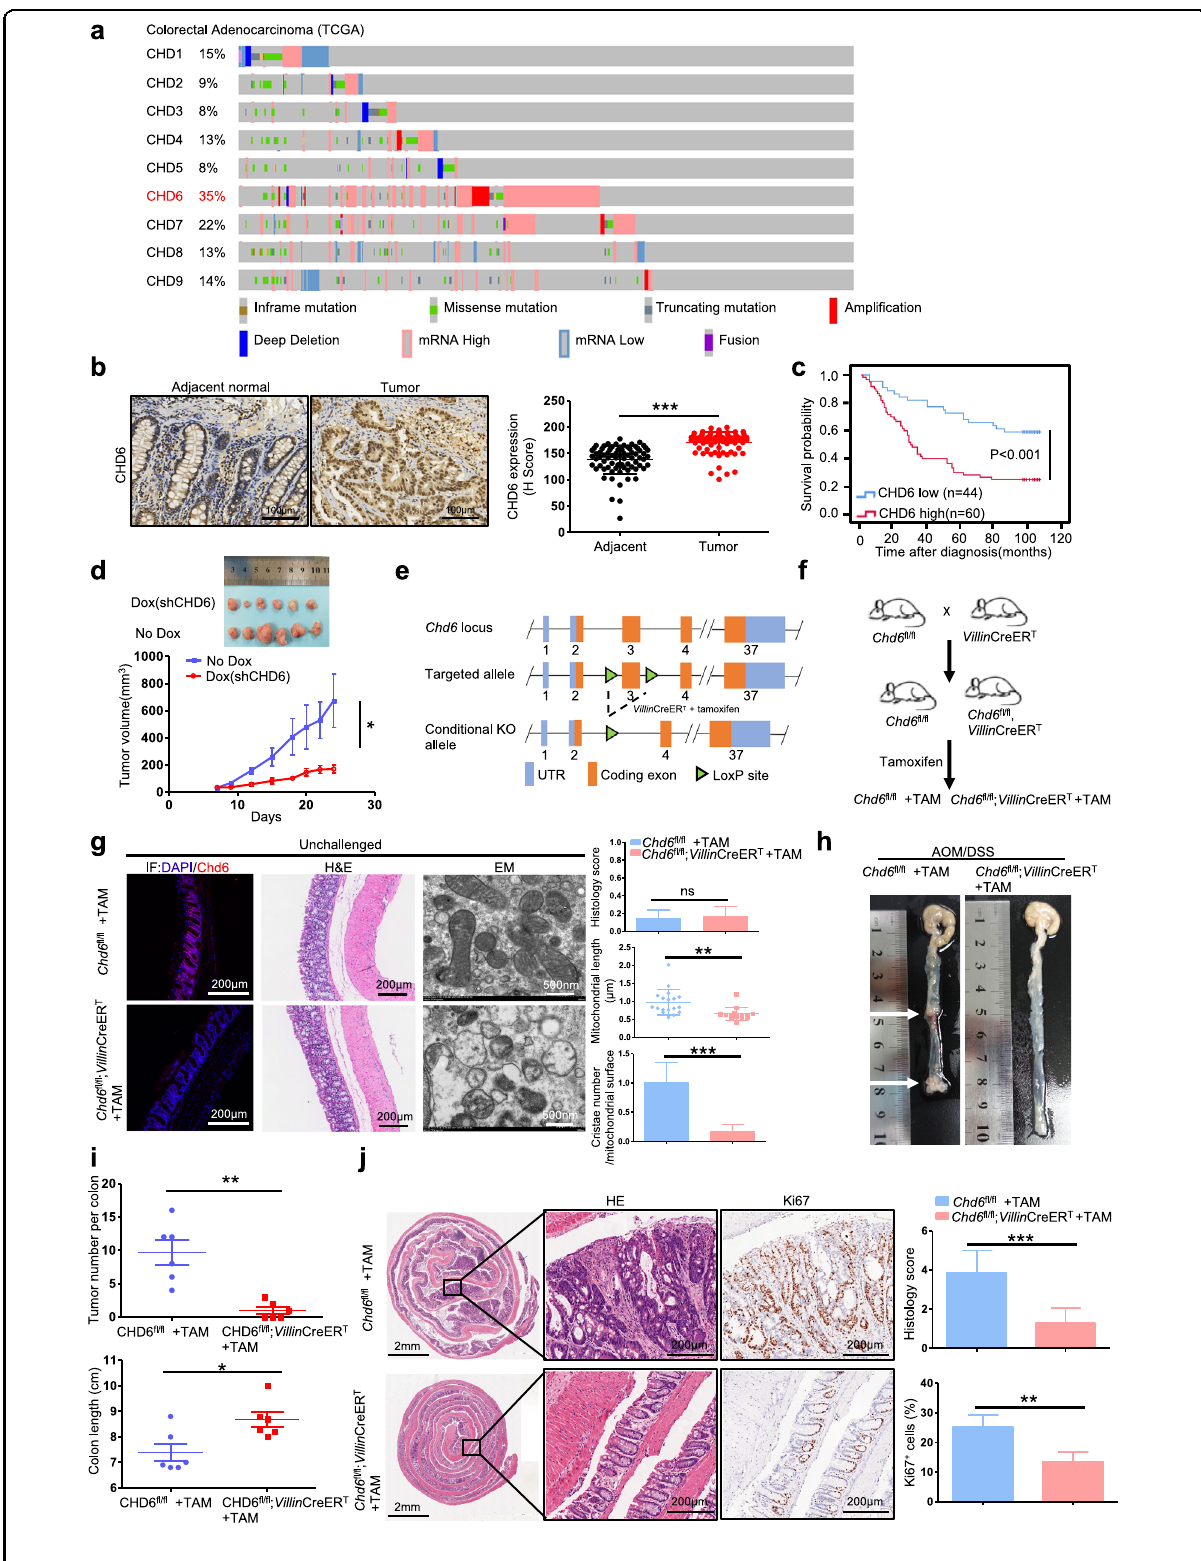
Fig. 1 (See legend on next